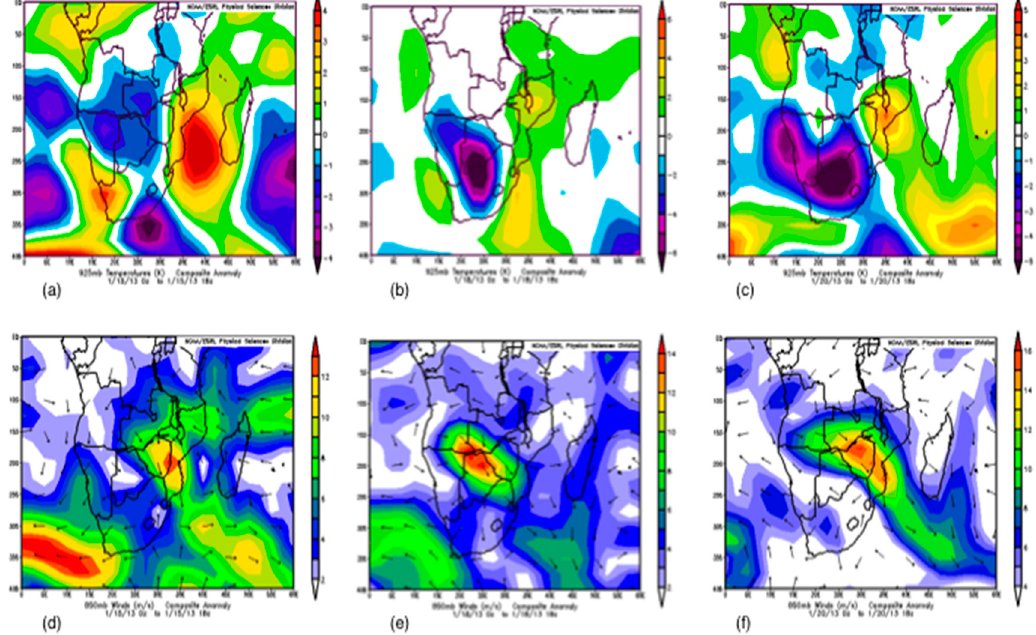
Figure 9. NCEP / NCAR re-analysis 925-mb temperature (K) and wind (ms − 1 ). Mean temperature ( a – c ) Figure 9 . NCEP/NCAR re-analysis 925-mb temperature (K) and wind (ms -1 ). Mean temperature and wind ( d – f ) over southern Africa. ( a , b , c ) and wind ( d , e , f ) over southern Africa.